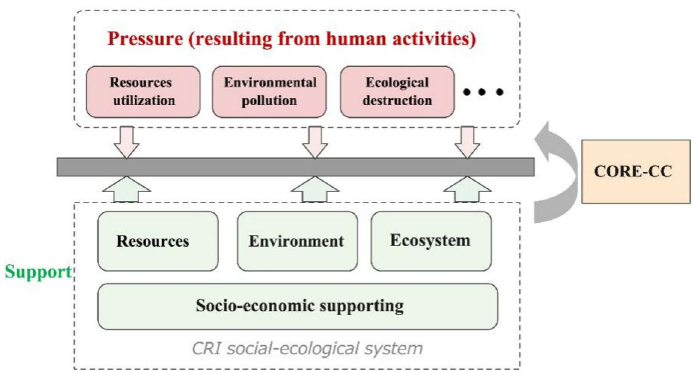
Figure 1. CORE-CC conceptual model. The ellipsis in the pressure box represents other human activities that interact with nature and exert pressure on the social-ecological